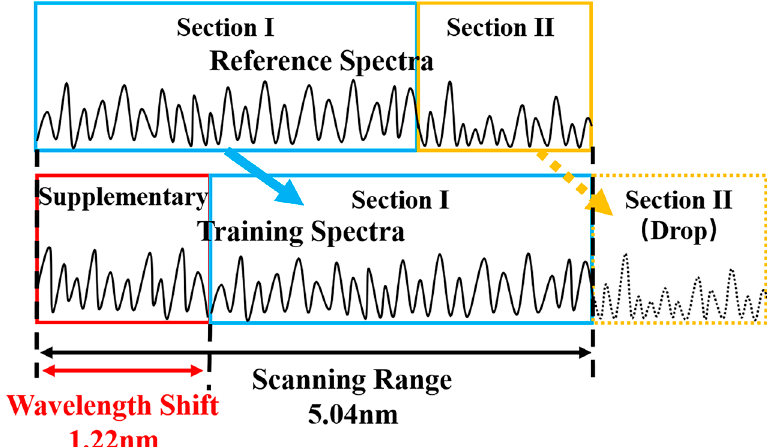
Figure 3. Generation of training set samples in the multilayer perceptron.